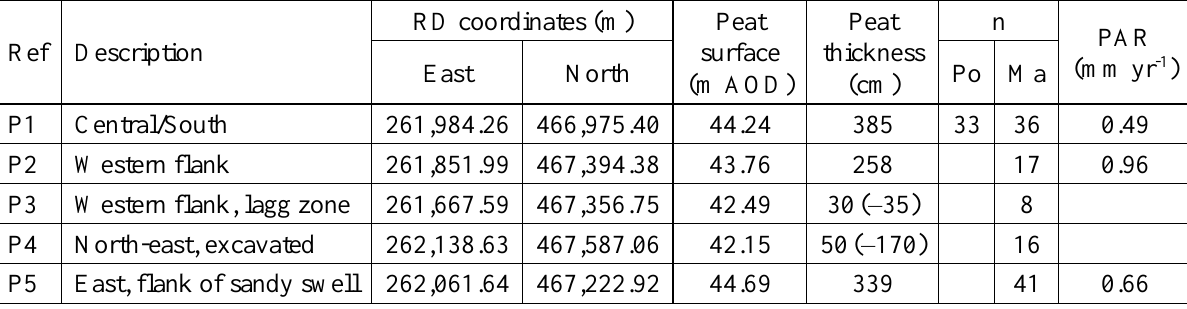
Table 1. Data on the palaeoecological cores studied. Po = number of pollen samples; Ma = number of